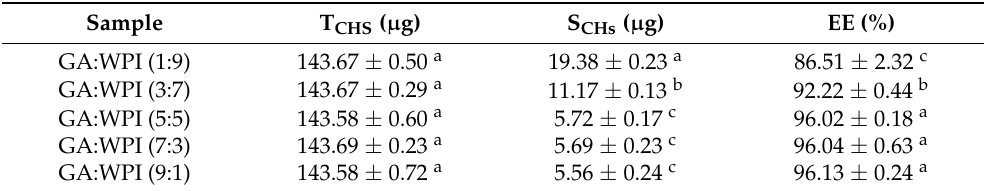
Table 3. The total chlorophylls (T CHs ), surface chlorophylls (S CHs ) and EE of microcapsules are